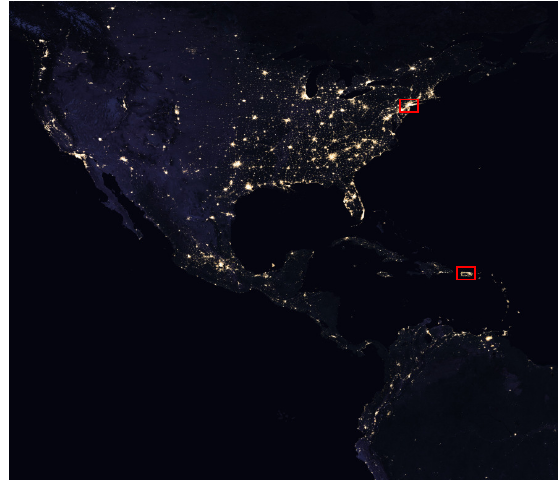
Figure 1. The NASA Black Marble annual composite NTL in 2016. The two red rectangular boxes represent the study areas of Puerto Rico and New York City and northeastern New Jersey.